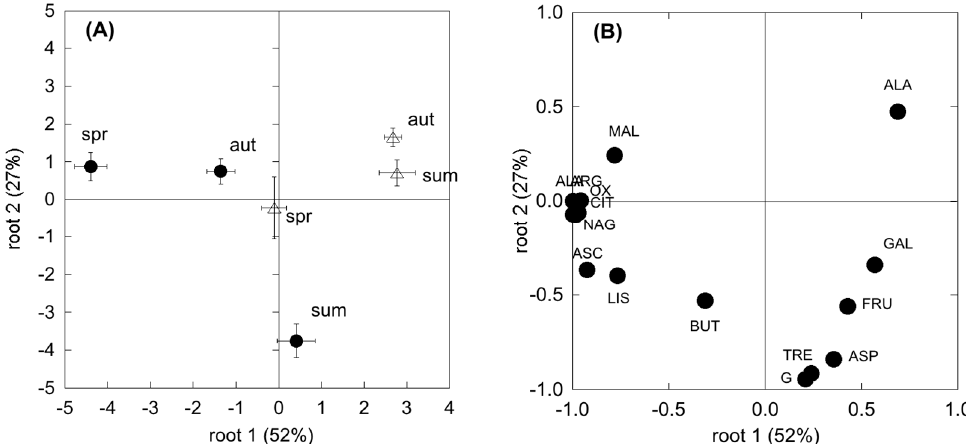
Figure 6. Principal Component Analysis (PCA) of the community level physiological profile (CLPP). ( A ) Factor coordinates of cases: empty triangles = WDS, full circles = SDS; Spr = spring, sum = Summer, aut = Autumn ( B ) factor loadings of variables; for labels see Table A2.